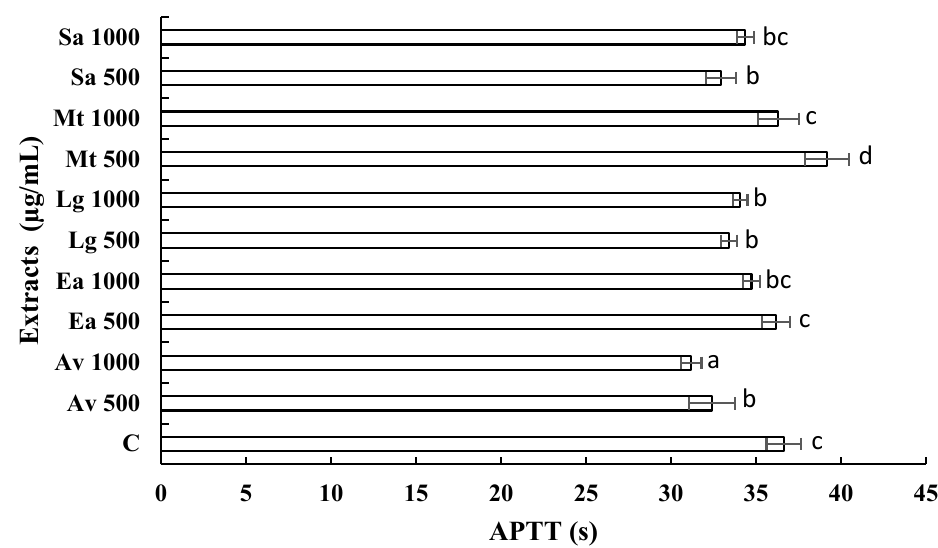
Figure 2. In vitro evaluation of the activated partial thromboplastin time (APTT) caused by A. vera (Av), E. arvense (Ea), L. graveolens (Lg), M. tenuiflora (Mt), and S. aromaticum (Sa) extracts at 500 and 1000 µg/mL. Data represent means in seconds (s) taken to control a healthy patient’s times (C). Differences between treatments were determined using Tukey’s post hoc test. Significant differences between treatment groups are represented by different letters, and equal letters indicate no significant difference between treatments.